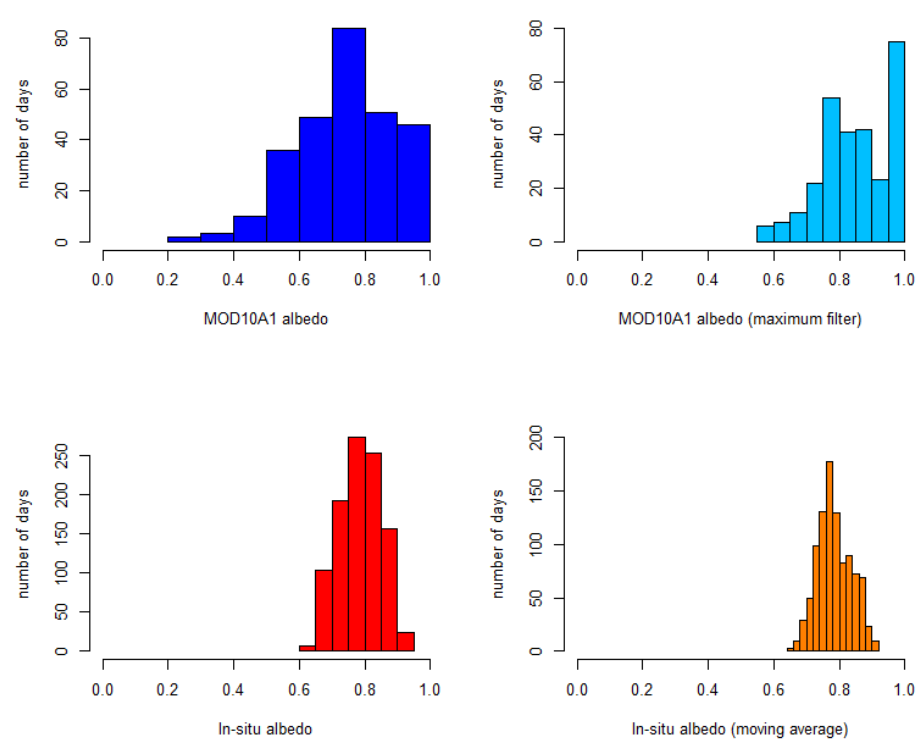
Figure 8. Histograms of in-situ and MOD10A1 albedo before and after filtering: MOD10A1 albedo (top left), MOD10A1 albedo (maximum filter) (top right), in-situ albedo (bottom left) and in-situ albedo (moving average) (bottom right).